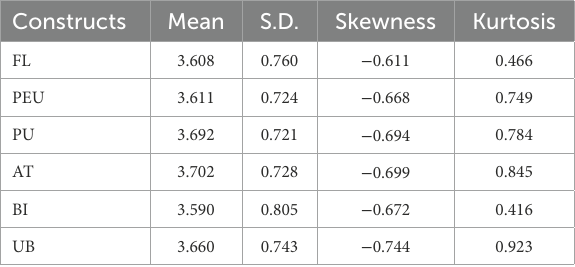
TABLE 4 Descriptive statistical